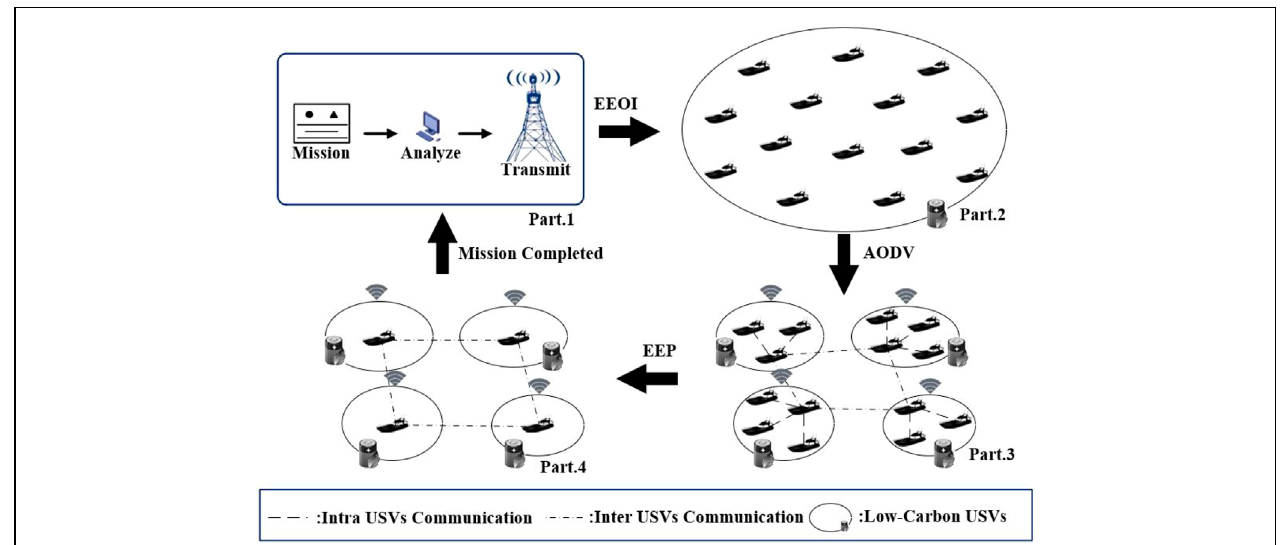
FIGURE 1 | Low-energy-consumption multilateral distributed cooperative control framework for multiple